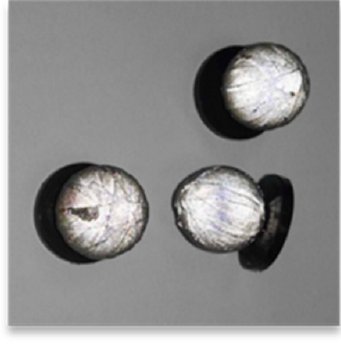
Figure 1. Passive and reflective markers used in this work.